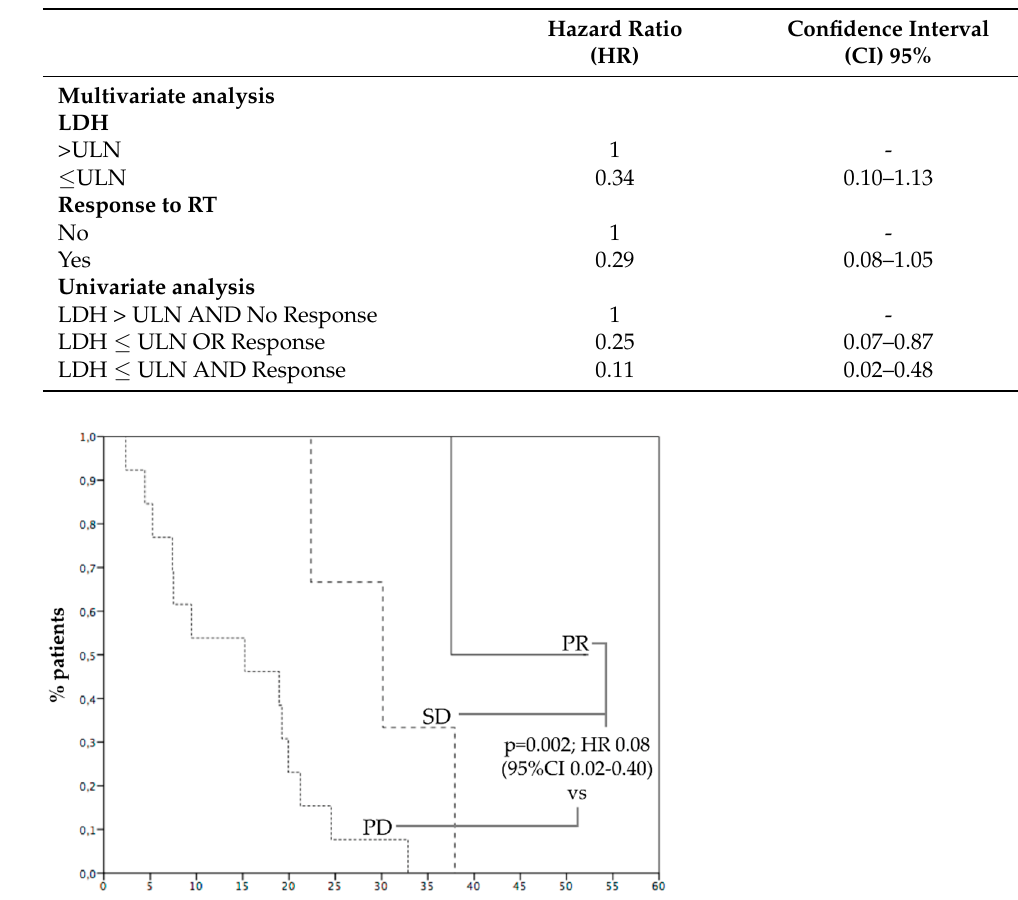
Table 3. Cox Regression of survival according to LDH and response to RT.